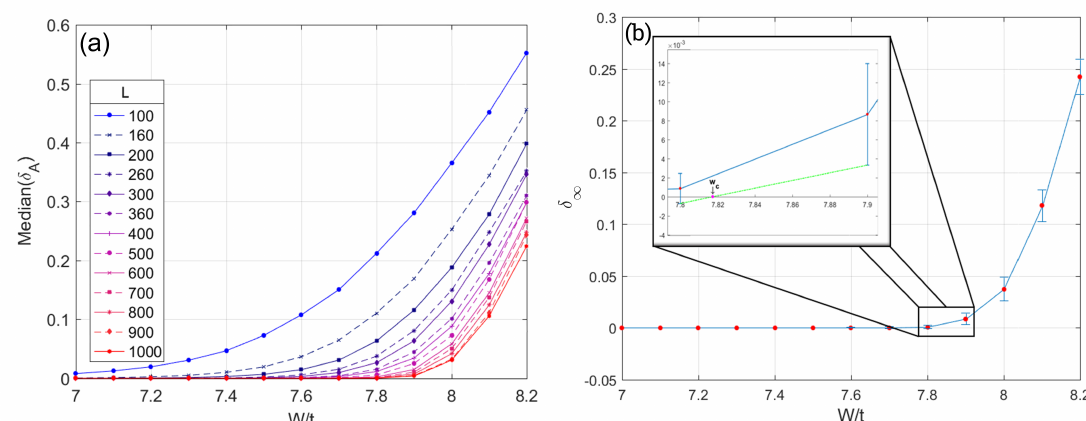
Figure 3. ( a ) The median (taken over 10 4 realizations) of the gap δ A between the first two eigenvalues of the single-particle entanglement spectrum [spectrum of the entanglement Hamiltonian, Equation (3)], as a function of the disorder W / t for L A / L = 1/2, ∆ / t = 0.6, µ = 0, and periodic boundary conditions, for different values of the total system size L . ( b ) The constant coefficient δ ∞ in fitting the L dependence of δ A to Equation (9) as a function of the disorder strength W / t . The inset shows a blow-up of the region where δ ∞ switches from zero to nonzero. Our method of determining the critical disorder strength W c is also indicated—see the text for further